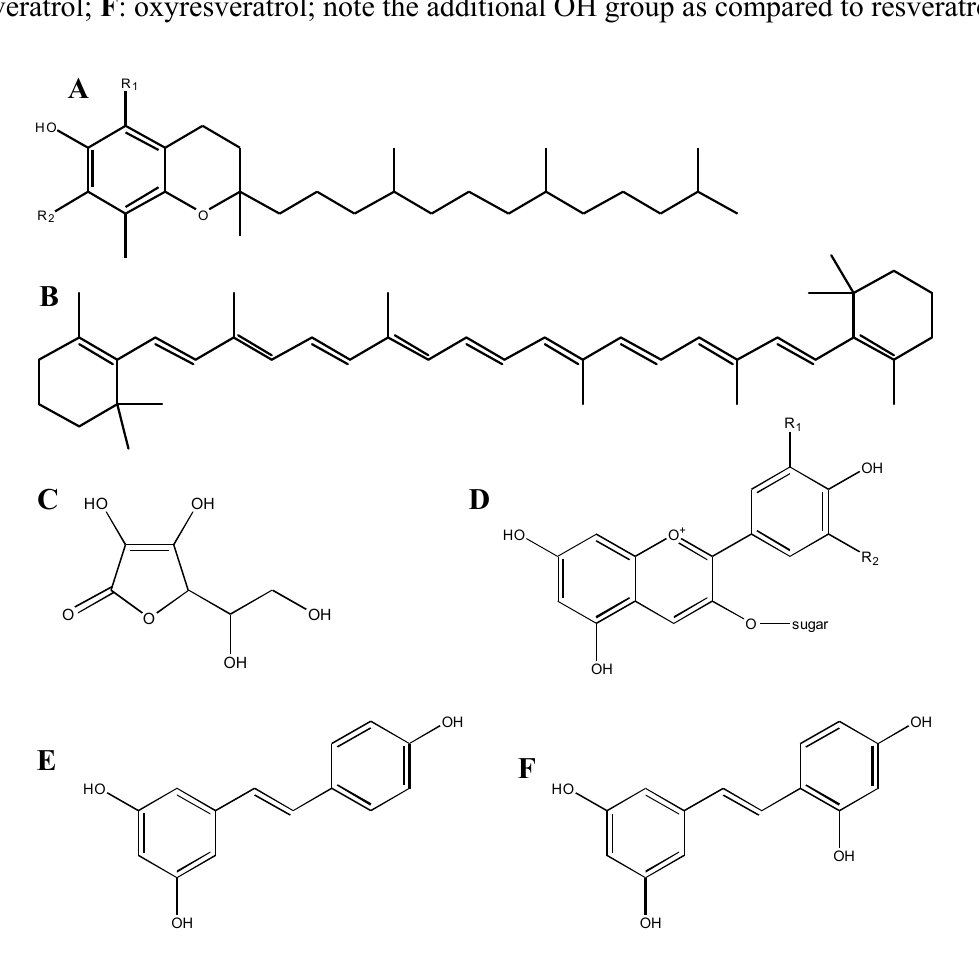
Figure 1. Structures of various antioxidant compounds. A : vitamin E (tocopherol); constituents at the R 1 and R 2 positions are either –H or –CH 3 ; B : beta-carotene, a member of the carotenoid family; C : vitamin C (ascorbic acid); D : anthocyanin; constituents at the R 1 and R 2 positions are –H, –OH or –OCH 3 , and the sugar is glucose, galactose or arabinose; E : resveratrol; F : oxyresveratrol; note the additional OH group as compared to